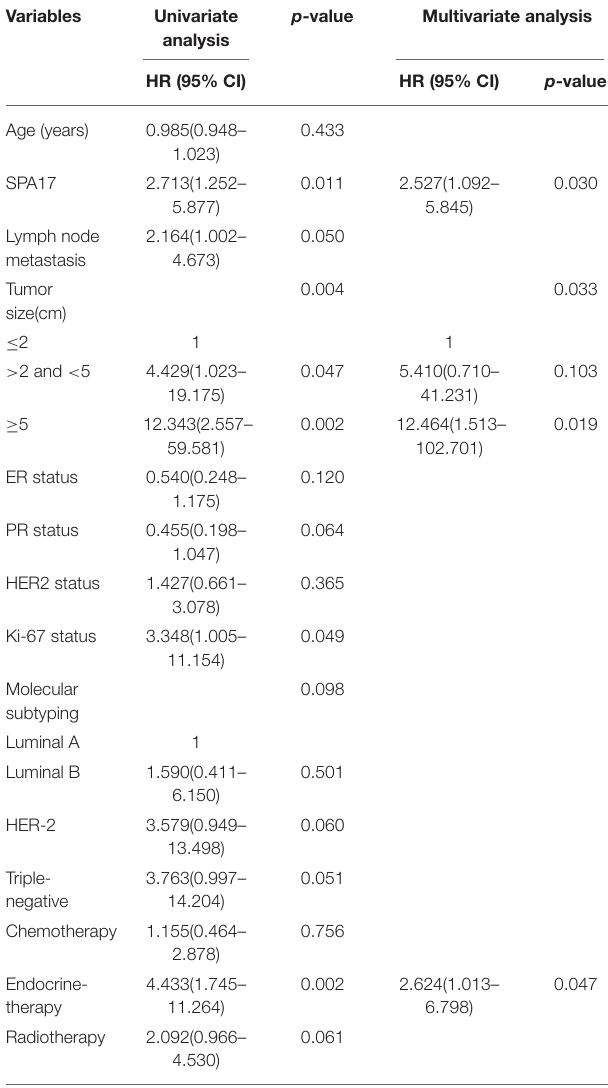
TABLE 2 | Association between clinicopathological features and overall survival—Cox regression analysis. Variables